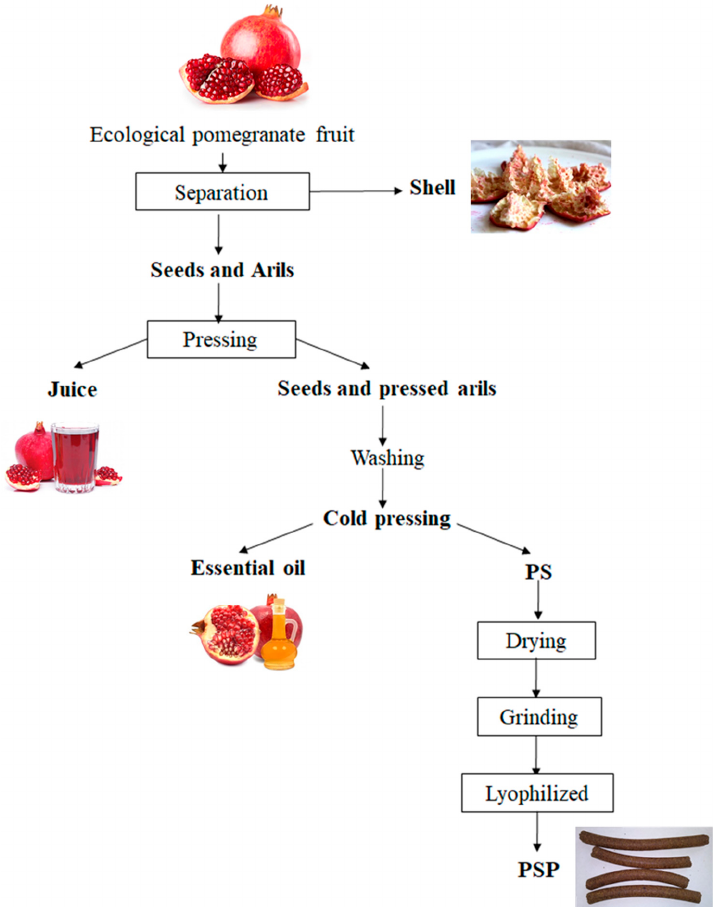
Figure 5. General scheme of PSP production from pomegranate industrial juice manufacturing.